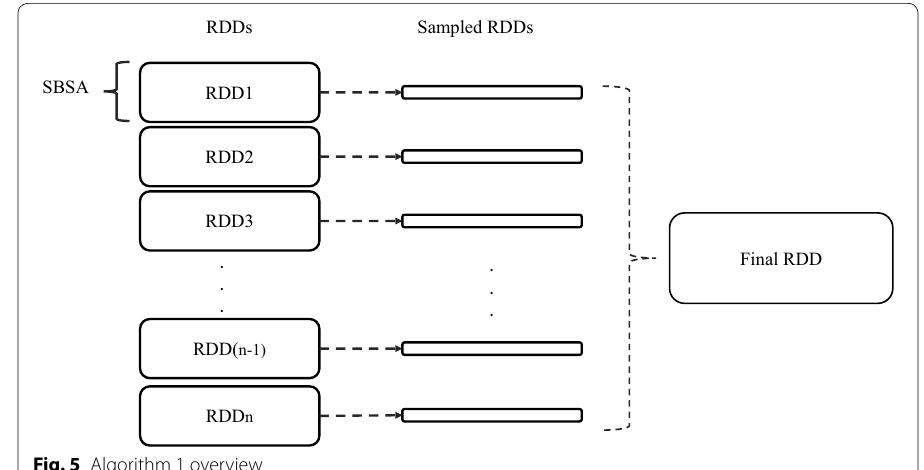
Fig. 5 Algorithm 1